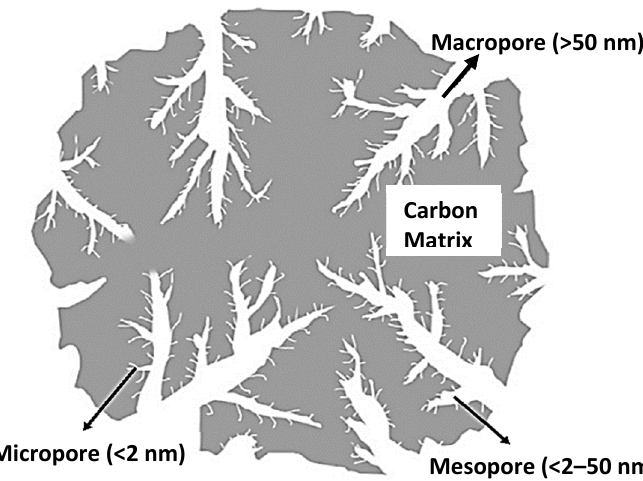
Figure 7. Porous structure of activated carbon [169].